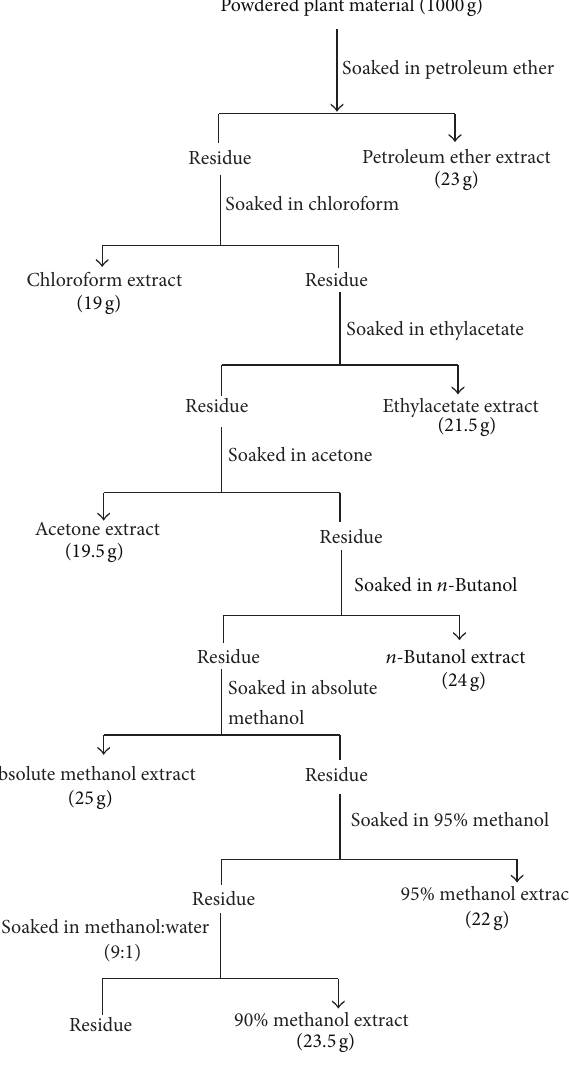
Figure 1: Schematic diagram showing preparation of extracts of C. viminalis